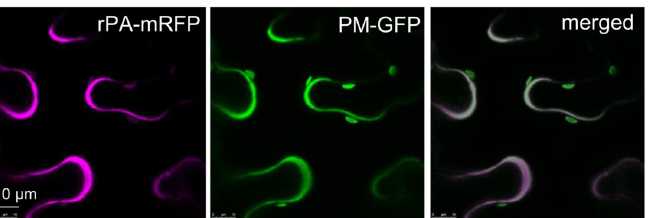
Fig 3. Subcellular localization of rPA-mRFP. Subcellular localization of rPA-mRFP was determined by live-cell imaging of infiltrated N . benthamiana leaf epidermal cells. rPA-mRFP was transiently co-expressed in N . benthamiana with EGFP-LTI6b (PM-GFP), a plasma membrane marker, and analyzed at 2dpi. The fluorescence (magenta) signal is typical of secreted proteins. Superposed images (merged) show significant co-localization of rPA-mRFP and PM-GFP. Scale bar is